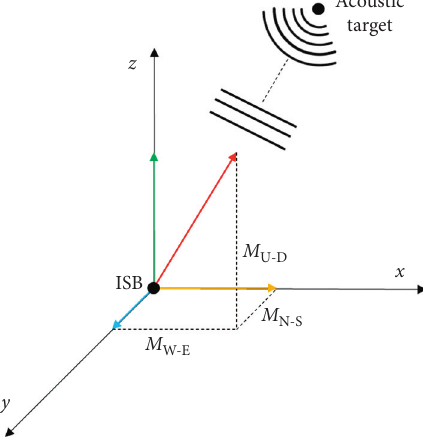
Figure 7: Explanation of a spatial direction vector.